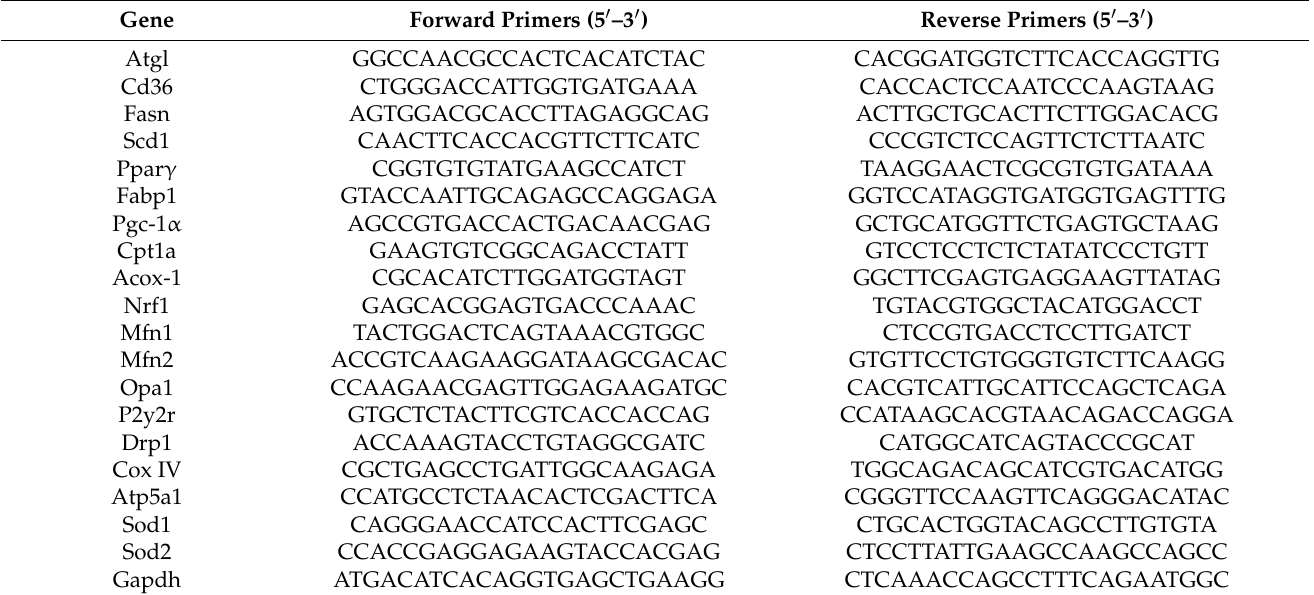
Table 1. The primer sequences used for real-time PCR analysis in this study.